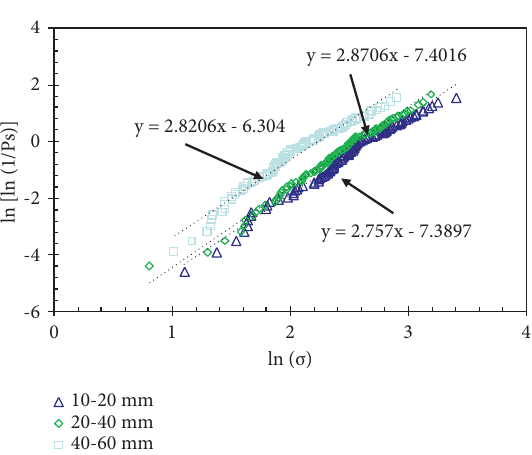
Figure 10: Weibull distribution diagram of particle crushing Table 4: Granular crushing strength of Weibull distribution